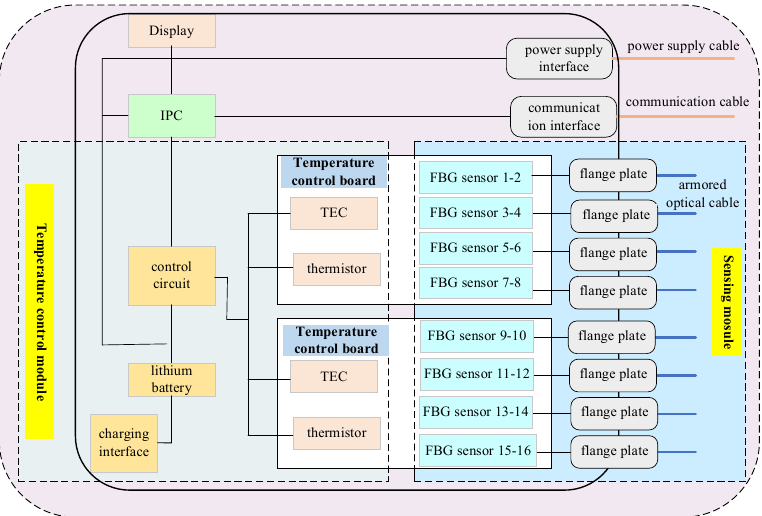
Figure 2. Hardware architecture of the fault detection instrument for FBG sensing system.